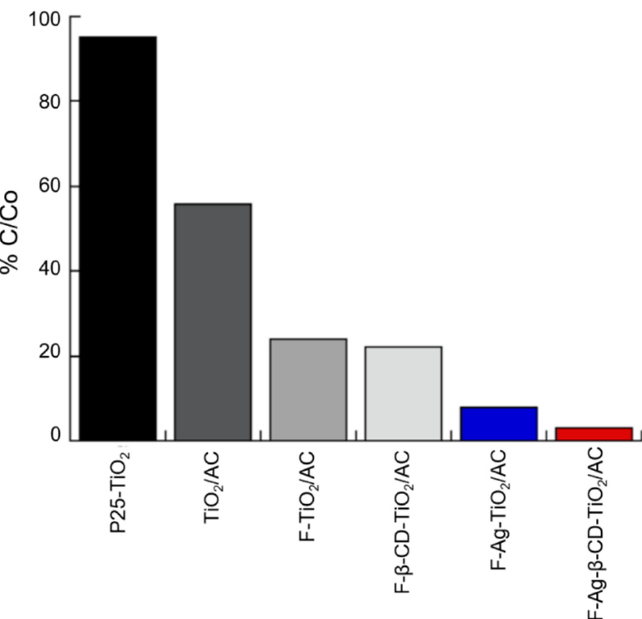
Figure 13. Photocatalytic degradation rate of naphthalene on seven different photocatalysts irradiated with visible light after 150 min of treatment [128].